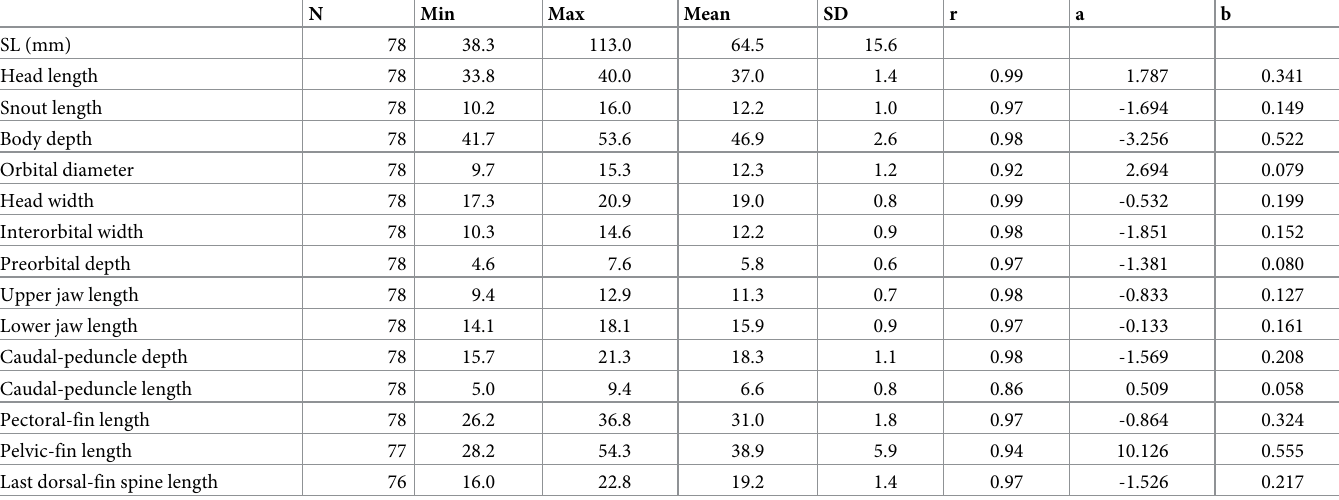
Table 11. Australoheros oblongus . Proportional measurements (per cent of SL) and linear regression parameters. N